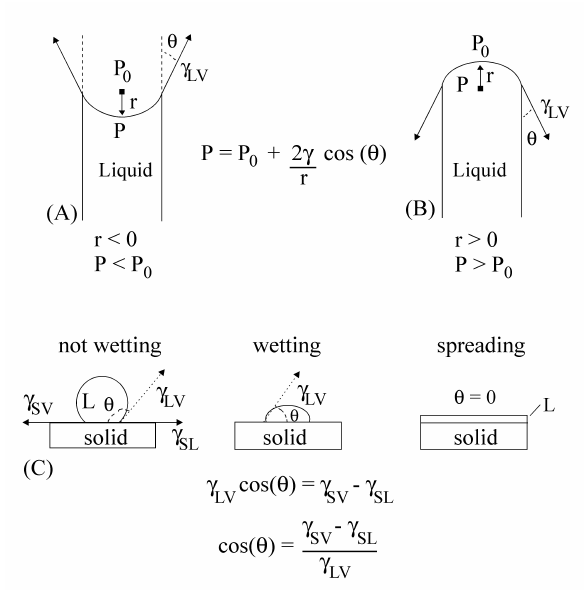
Figure 1. Liquid-solid-gas interface: A - liquid internal pressure, P, smaller than atmospheric pressure, P 0 ; B- P > P 0 turning positive the curvature radius; C- liquid behavior on a solid surface for several wetting